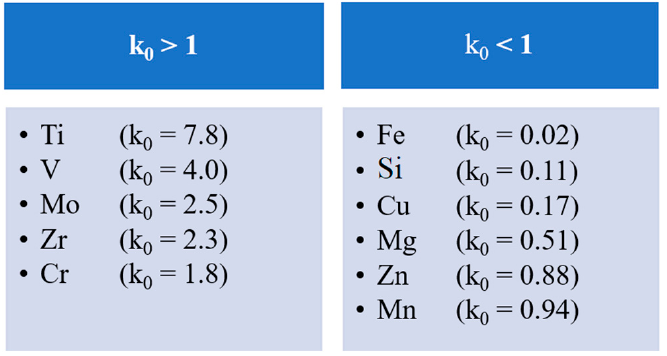
Figure 2. Partition coefficients (k 0 ) of alloying elements [20] .